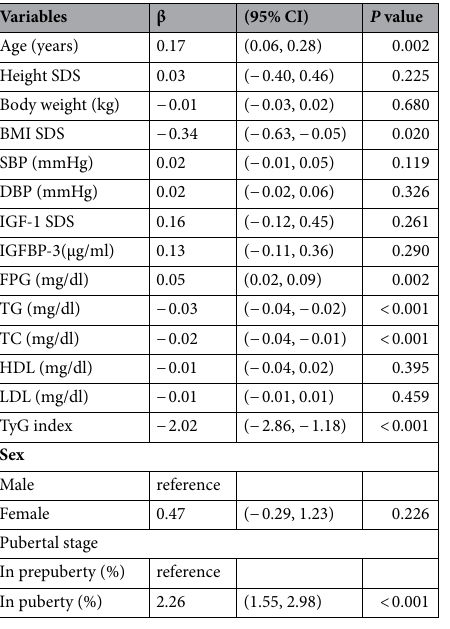
Table 2. Association between GH peak and different variables. Abbreviations: Height SDS: height standard deviation scores; BMI SDS: body mass index standard deviation scores; IGF-1 SDS: insulin like growth